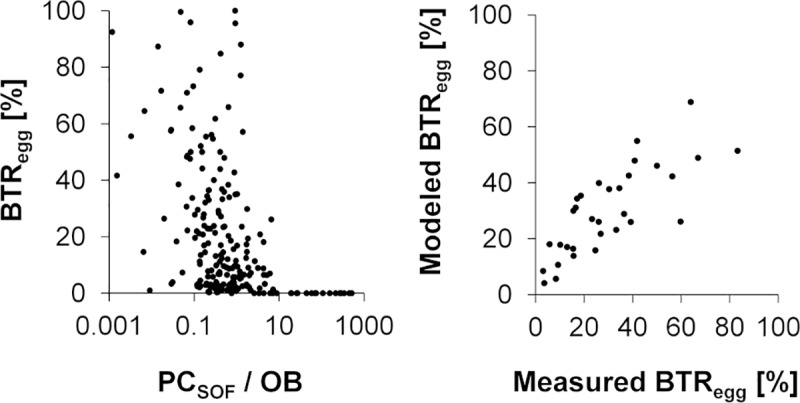
Left: Dependence of BTRegg
on the ratio of pollen cells on same or opposite frame to open brood cells. Right: Model fit of a best fit GLM for BTRegg considering impact of capped and open brood cells and pollen cells (model no. 3 in Table 2).